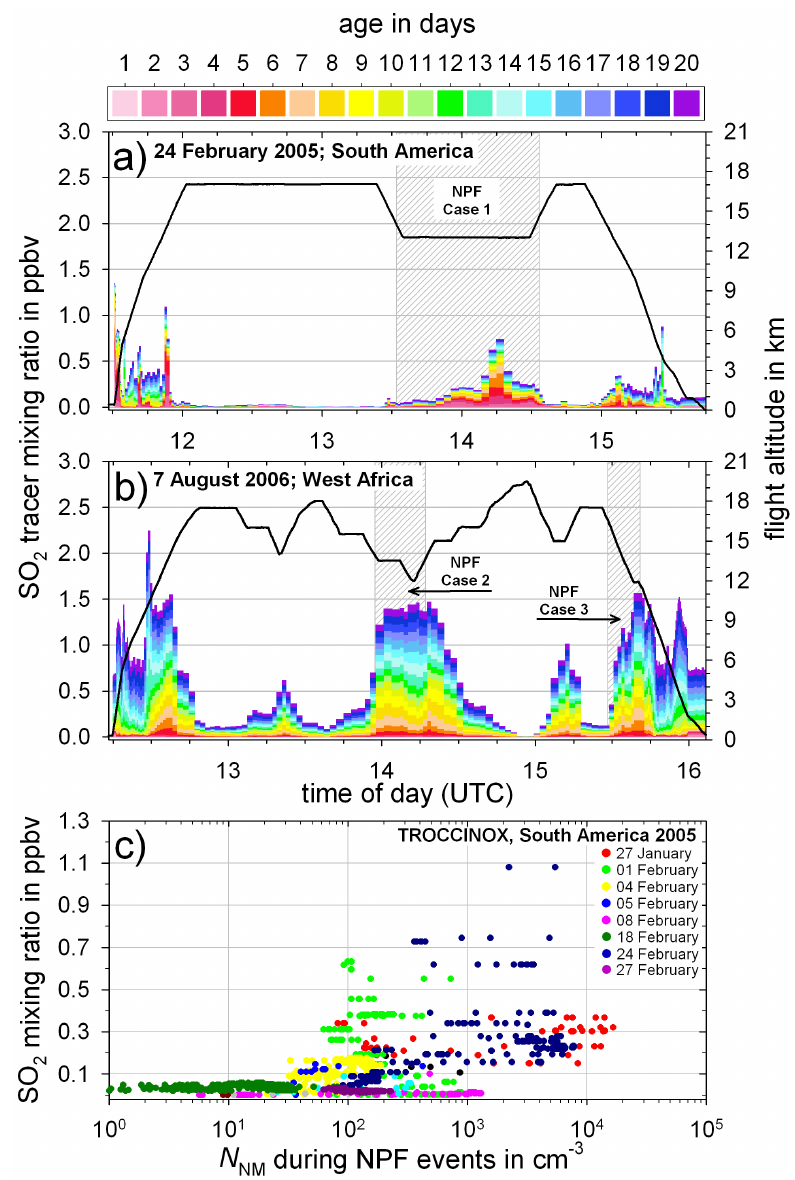
Fig. 5. FLEXPART trajectory model simulation of SO 2 mixing ratio (upper envelope of colored regions) along the flight track (black line). (a) TROCCIONOX NPF event Case 1. (b) SCOUT-AMMA NPF event Cases 2 and 3. FLEXPART predicts high SO 2 values exactly for the NPF events. Color code: age along trajectory since most previous SO 2 emission (see text for details). (c) Relation between N NM during NPF and predicted SO 2 by FLEXPART. When SO 2 mixing ratios were predicted to be enhanced NPF was